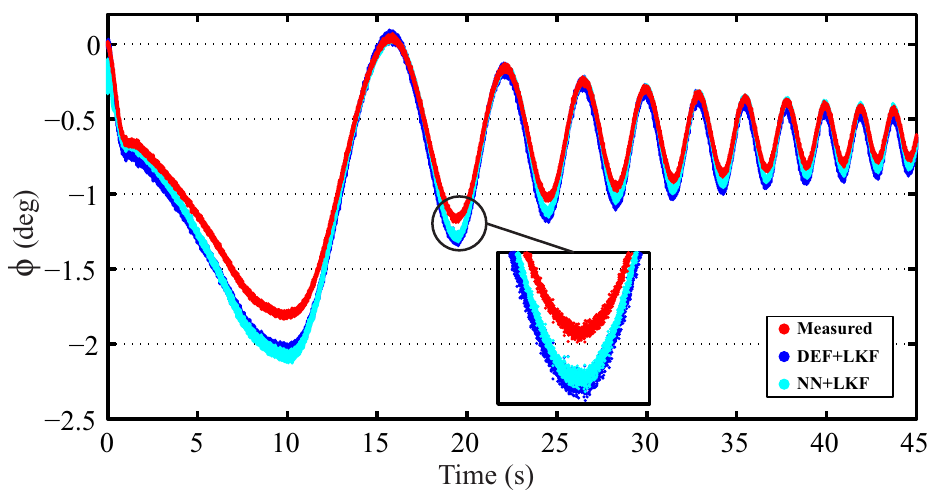
Figure 8. Simulation results for a sine sweep maneuver at 70 km/h with a friction coefficient of 0.3 (red points: measured; blue points: DEF + LKF; cyan points: NN + LKF).